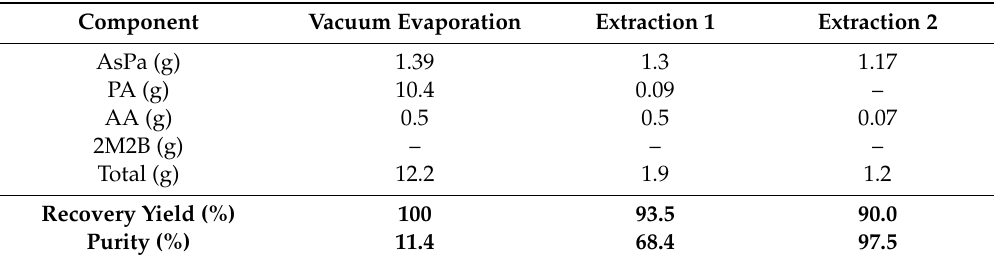
Table 4. Composition, recovery yield and purity of ascorbyl palmitate (AsPa) at each step of the purification process.